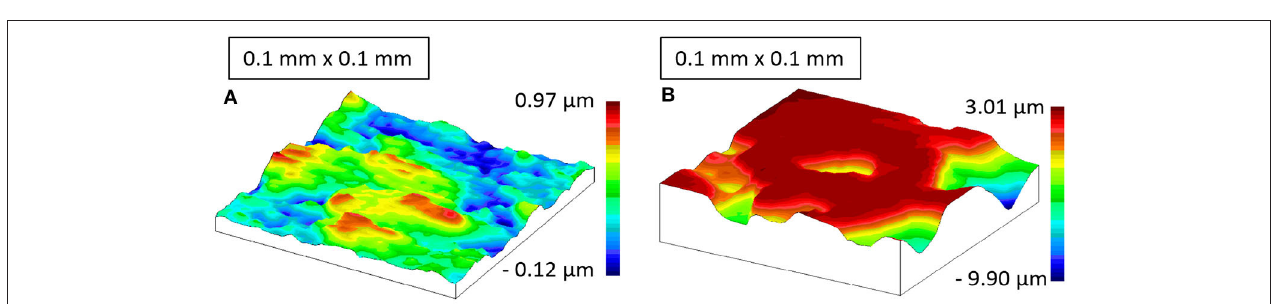
FIGURE 10 | Surface details of wear by abrasion (A) Sdq = 0.063; Sdr = 0.139%; (B) Sdq = 0.304; Sdr = 4.090%.